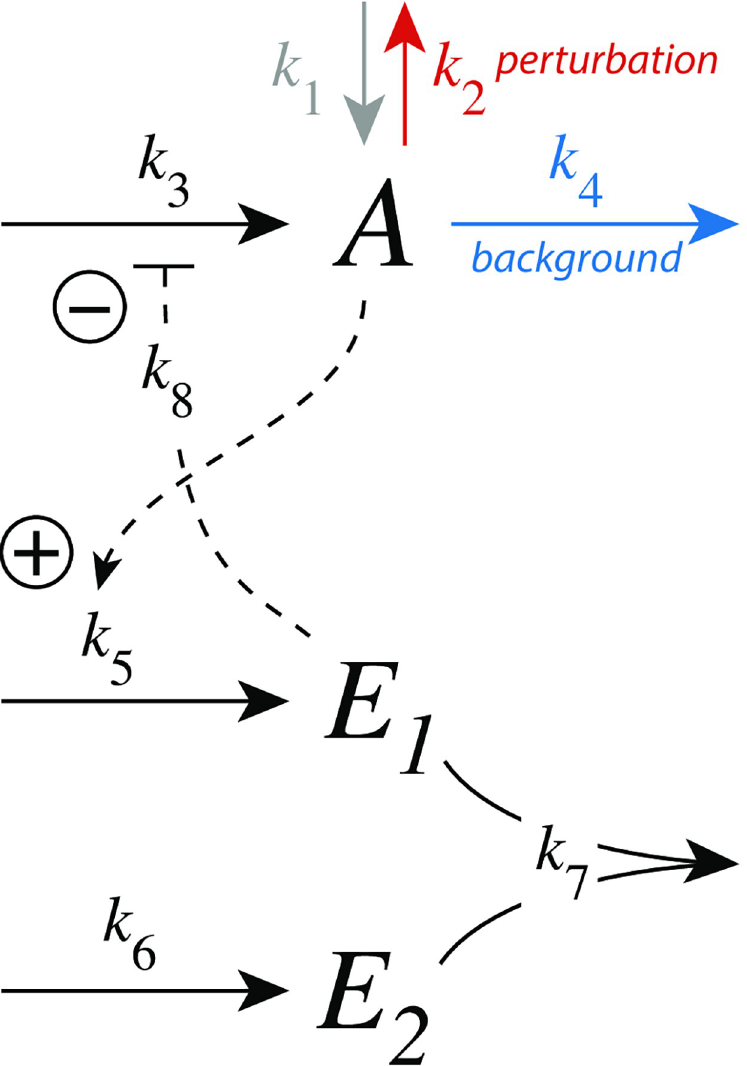
Fig 9. Controller motif m2 with antithetic integral control. Here, antithetic control is implemented as a bimolecular second-order reaction which removes the two controller molecules E 1 and E 2 . See text on how A ’s set-point is